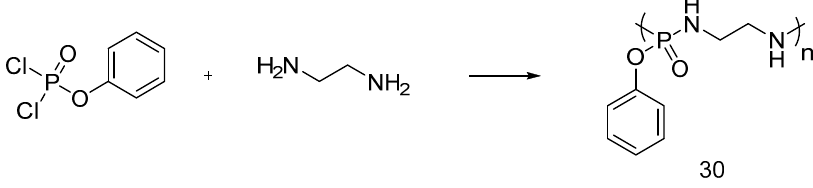
Figure 21. Representative synthesis of poly(phoshorodiamidate) ( 30 ).